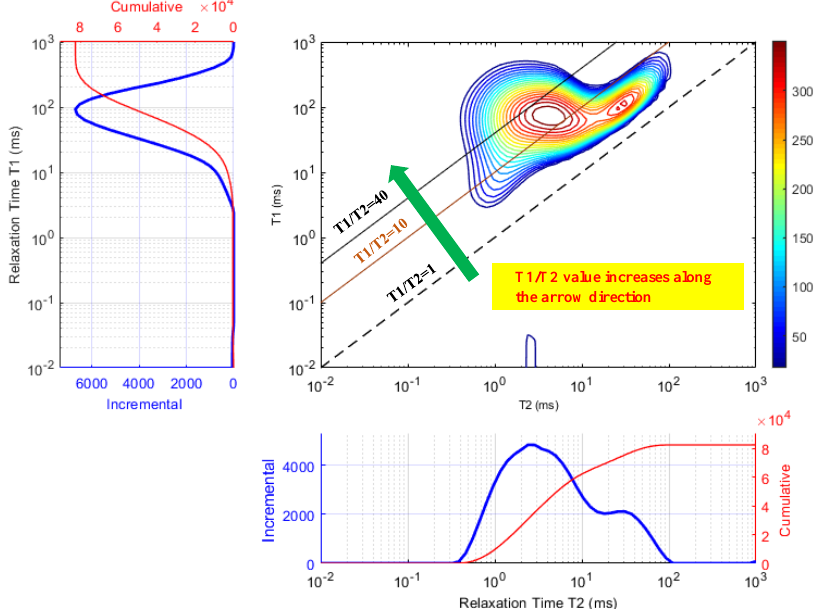
Figure 10. 2D NMR map of Core J1 in the saturated oil state. The blue line corresponds to the signal value increment, and the red line corresponds to the cumulative signal value.